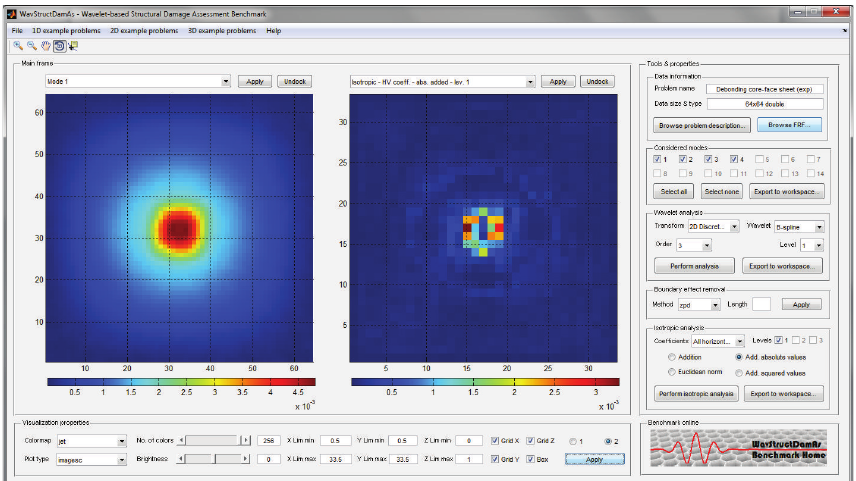
Figure 11: The benchmark results for SDI in a sandwich plate using isotropic DWT-based